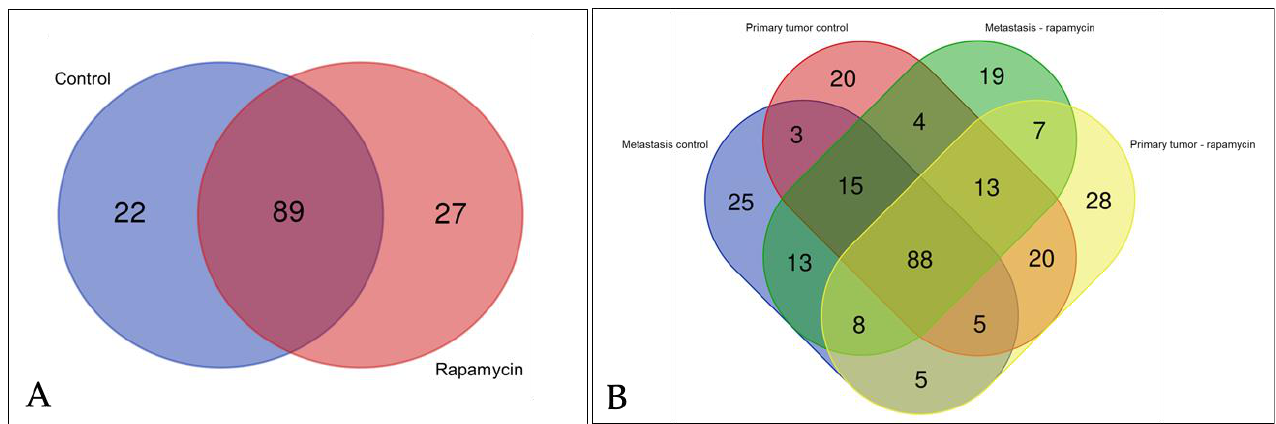
Figure 1. Venn diagram considering similar and different proteins found in all different groups studied. ( A ). represents all proteins found in control and rapamycin treated group. ( B ). shows proteins found in metastasis control, primary tumor control, metastasis rapamycin and primary tumor rapamycin groups.